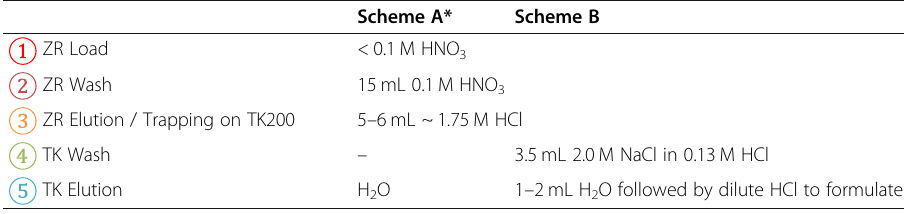
Table 1 High level schemes of [ 68 Ga]GaCl 3 purifications